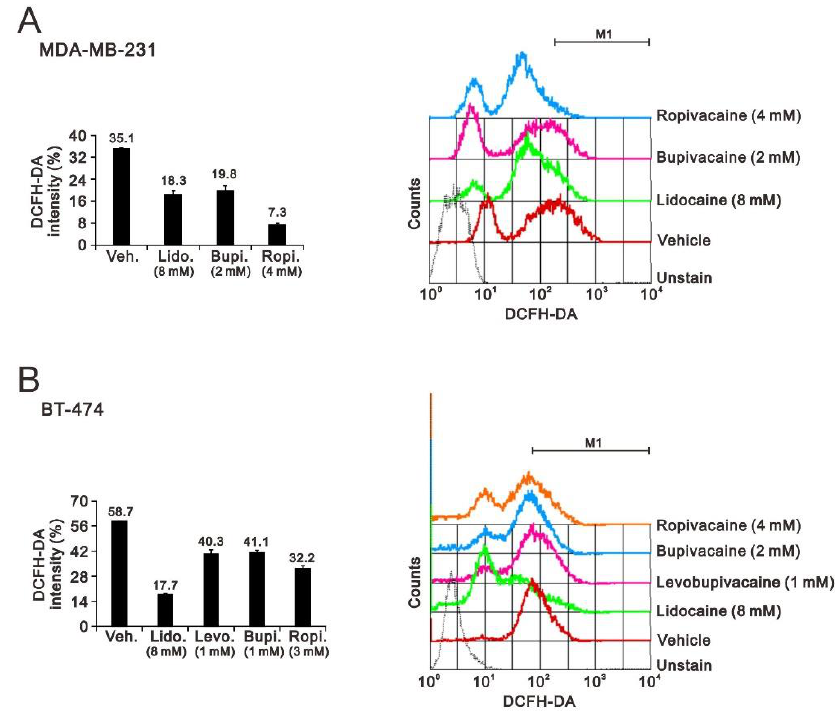
Figure 5. The effects of the local anesthetics on cell ROS status in MDA-MB-231 and BT474 cells. ( A ) MDA-MB-231 and ( B ) BT-474 (3 × 10 5 ) cells were treated for 24 h with the indicated concentrations of the local anesthetics. The cell ROS status was determined using 20 µ M of DCFH-DA and measured using flow cytometry. The cell volume gating strategy involved FSC-H and SSC-H. The median DCFH-DA fluorescence intensity of the vehicle was used as the starting point for M1 gating. The results are representative of two independent experiments. Bars depict the mean ± SD.